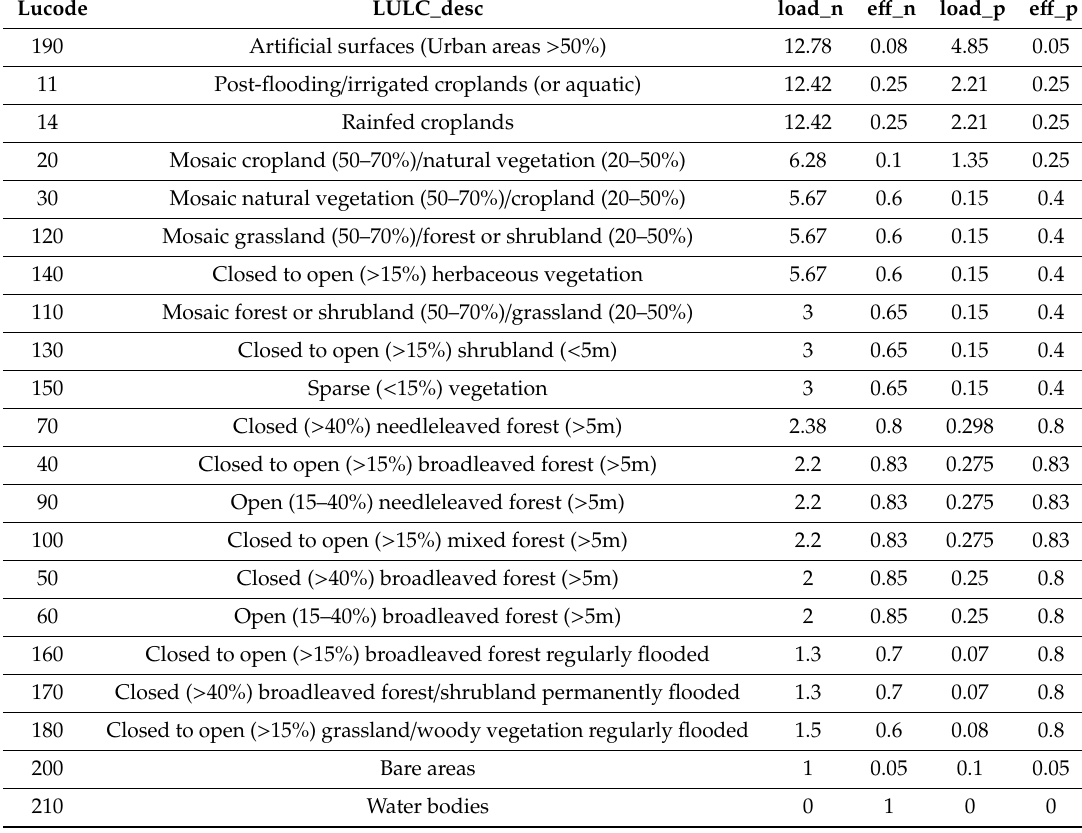
Table A2. Biophysical table used for scenarios using the GlobCover land cover dataset.